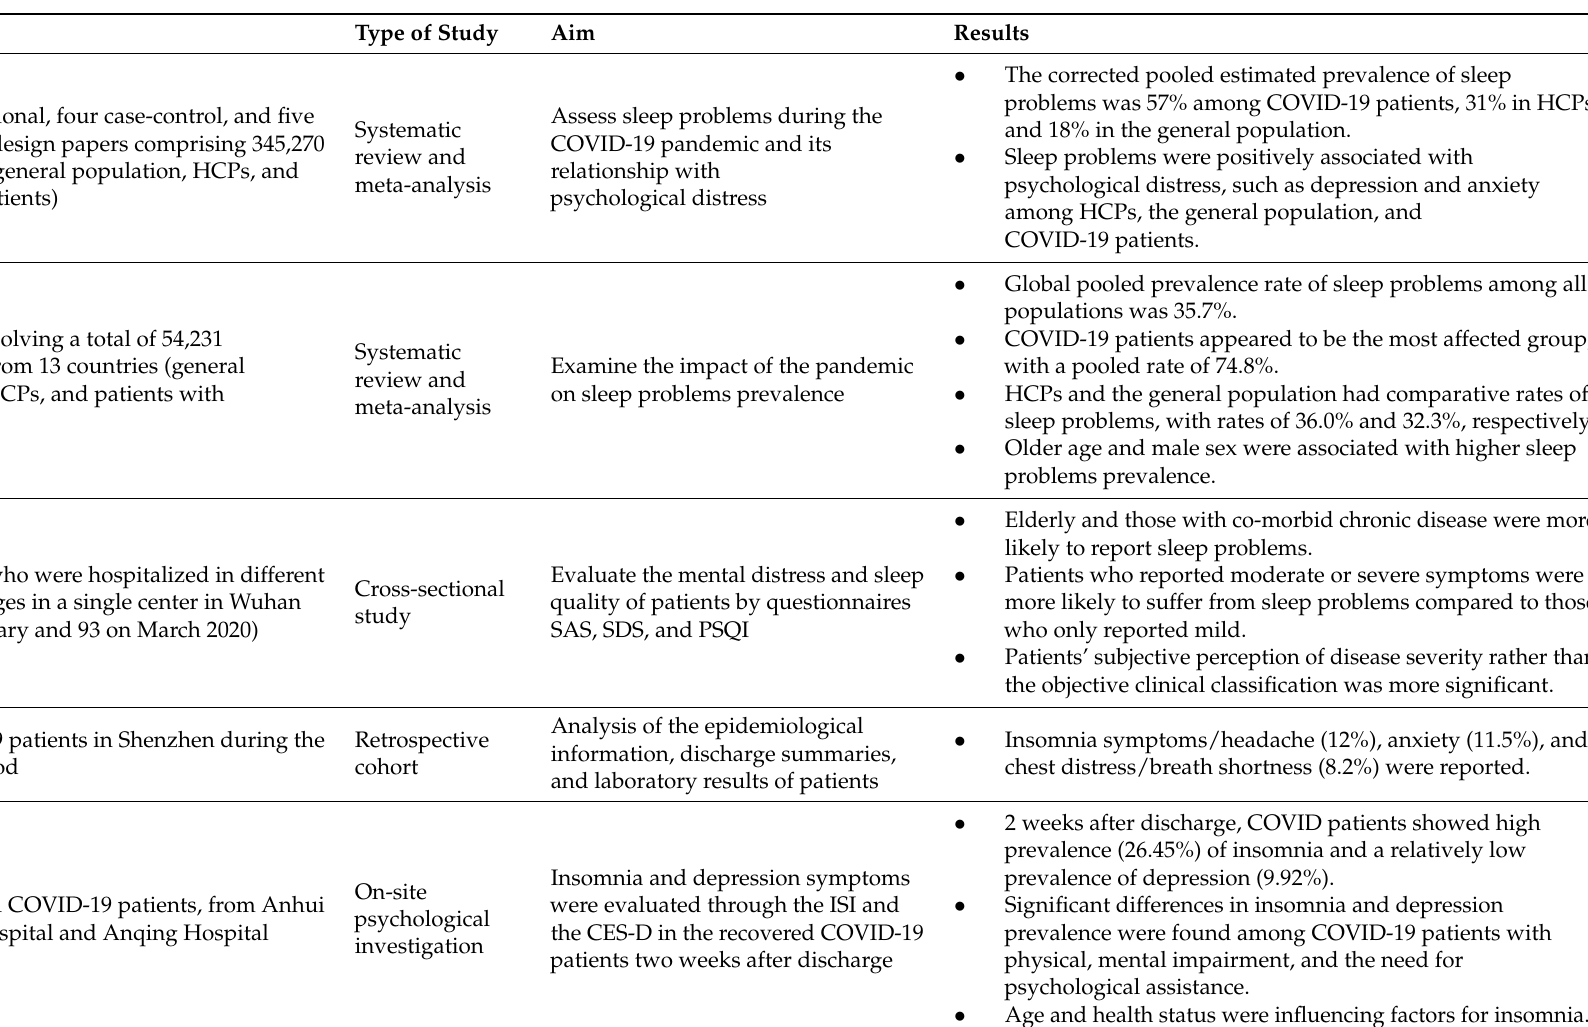
Table 1. Main findings of the studies assessing the sleep quality of COVID-19